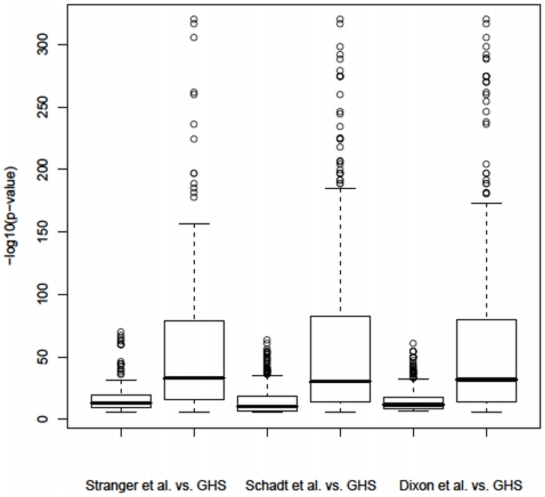
Comparison of the distributions of P-values of cis eQTLs reported as significant in three previous association studies with P-values observed in GHS for the same eQTLs.For each of the 3 comparisons, we selected in GHS the subset of gene expressions claimed as significant in the study of comparison. Only autosomal genes were considered in these comparisons. The data used to generate this figure are provided in Files S2–S4. See also footnote of Table S3 for details.